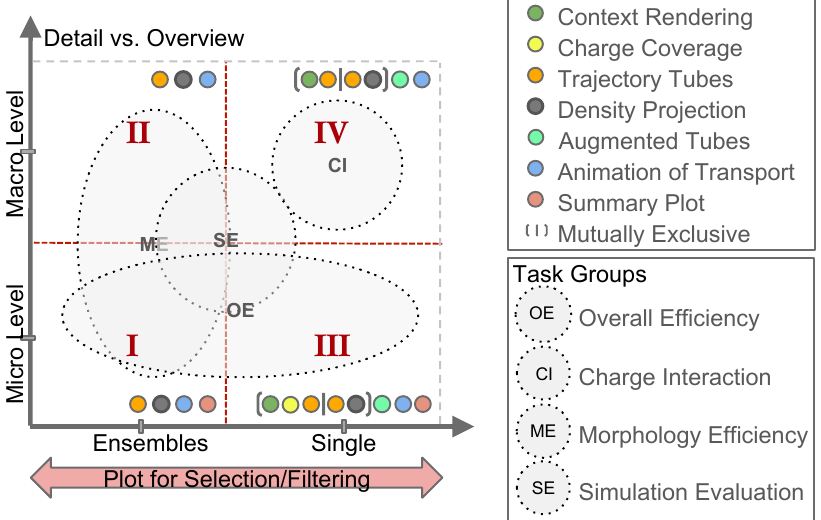
Figure 2. Our visualization parameter space can be roughly divided into four quadrants micro-level vs. macro-level of detail, ensemble vs. single trajectory). The parameter space can be investigated using several visualization techniques, which are associated with the four identified task groups. To move between the single and the ensemble level, brushing-and-linking is realized using